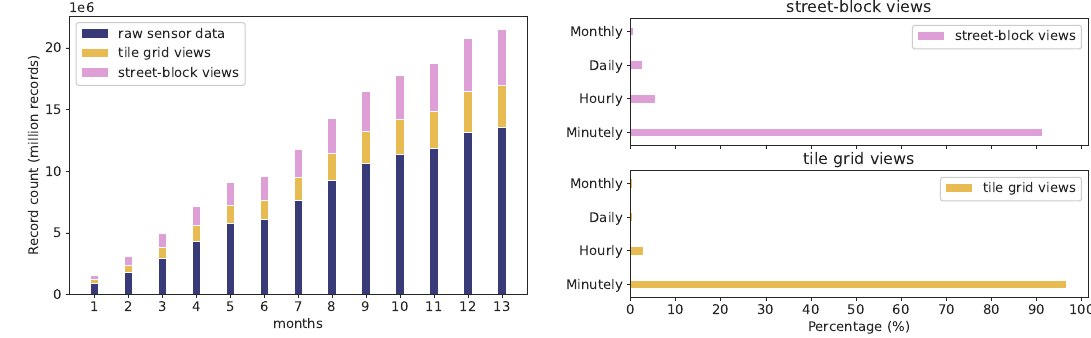
Figure 13. Storage footprint of continuous